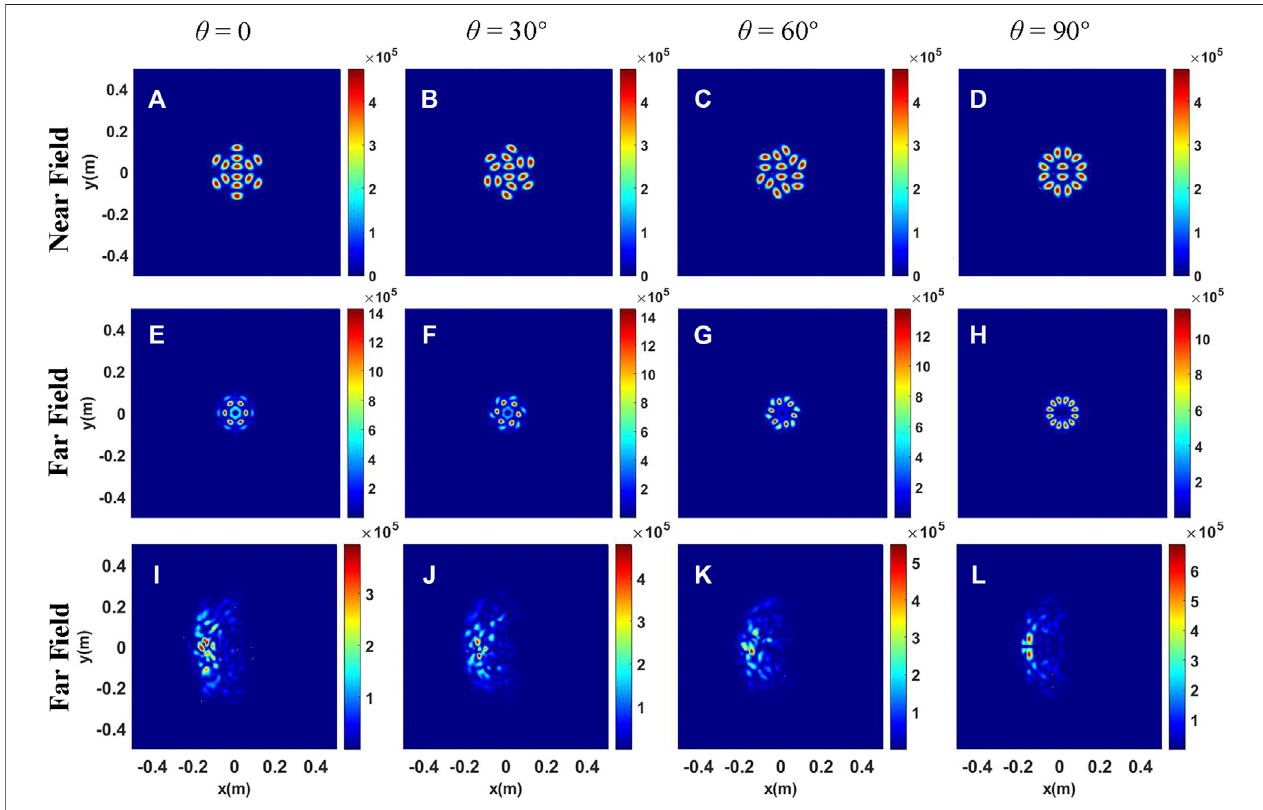
FIGURE 4 | Intensity distributions of the LP 11 mode beam array with different rotation angles of beamlets. (A – D) Intensity distributions at the initial plane; (E – H) Intensity distributions at the receiver plane in free space; (I – L) Intensity distributions at the receiver plane under thermal blooming.